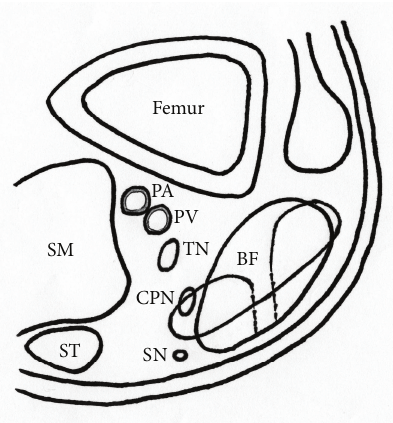
Figure 4: Schema of common peroneal nerve entrapped by surgical suture. BF, biceps femoris muscle; CPN, common peroneal nerve; PA, popliteal artery; PV, popliteal vein; SM, semimembranosus muscle; SN, sural nerve; ST, semitendinosus muscle; TN, tibial